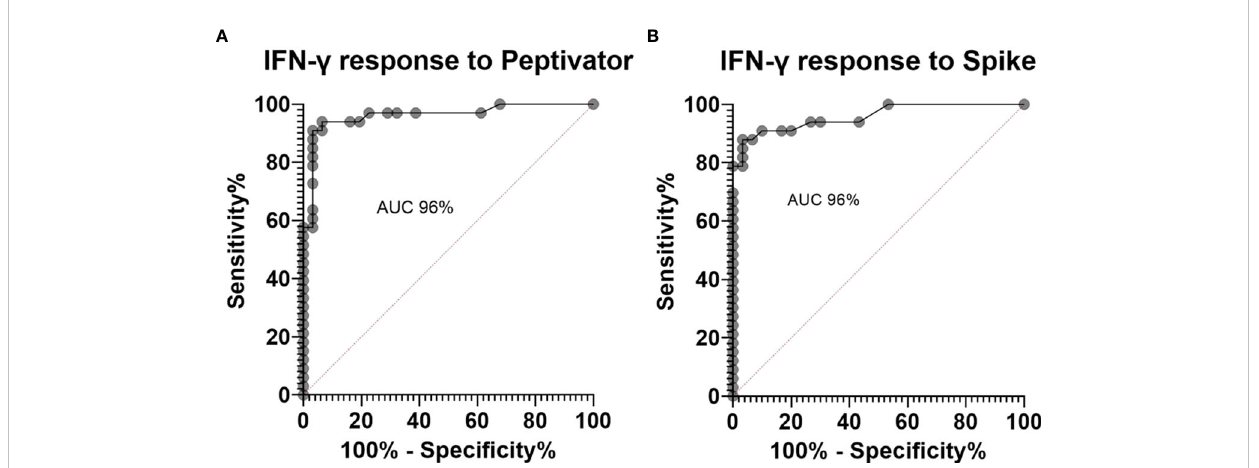
FIGURE 1 Receiver operator curves for healthy controls pre-vaccination compared to post primary vaccination showing (A) . an area under the curve (AUC) of 96% for interferon gamma (IFN- g ) response to peptide (S, S1, S+) mix stimulation and (B) . an AUC of 96% for IFN- g response to spike protein stimulation.